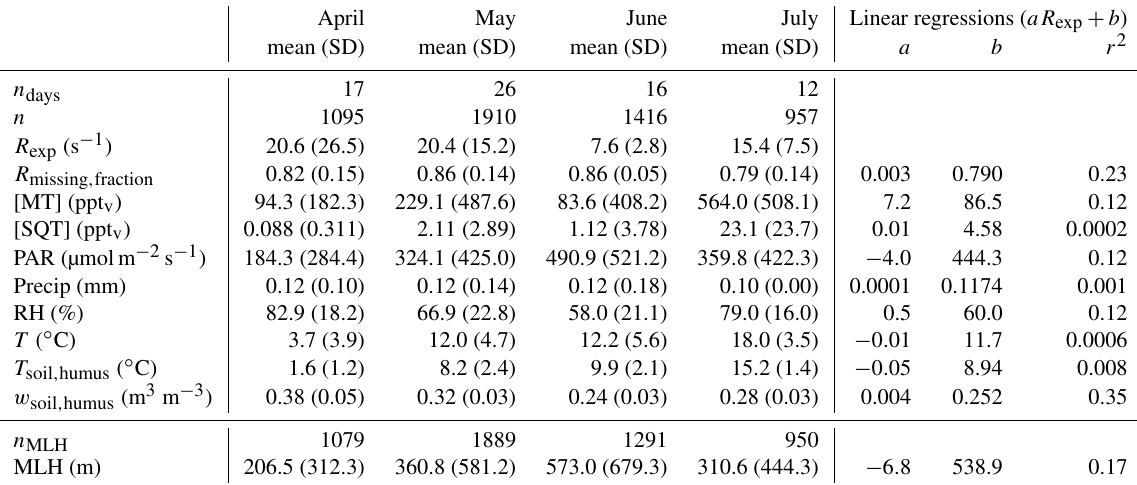
Table 1. Monthly means and standard deviations (SD) of experimental total OH reactivity ( R exp ), the missing OH reactivity frac- tion ( R missing , fraction ), monoterpene and sesquiterpene mixing ratios ( [ MT ] and [ SQT ] , respectively), photosynthetically active radiation (PAR), precipitation (Precip), relative humidity (RH), air temperature ( T ), surface soil temperature ( T soil , humus ), surface soil water content ( w soil , humus ), and mixing layer height (MLH). Coefficients a and b from linear regressions between the weekly means of these variables and weekly averaged R exp and the corresponding coefficients of determination ( r 2 ). n days indicates the number of days with measurements. n denotes the number of R exp observations. Note that all other means (except MLH) have been derived for the same measurement period as R exp . n MLH indicates the number of observations with overlapping R exp and MLH